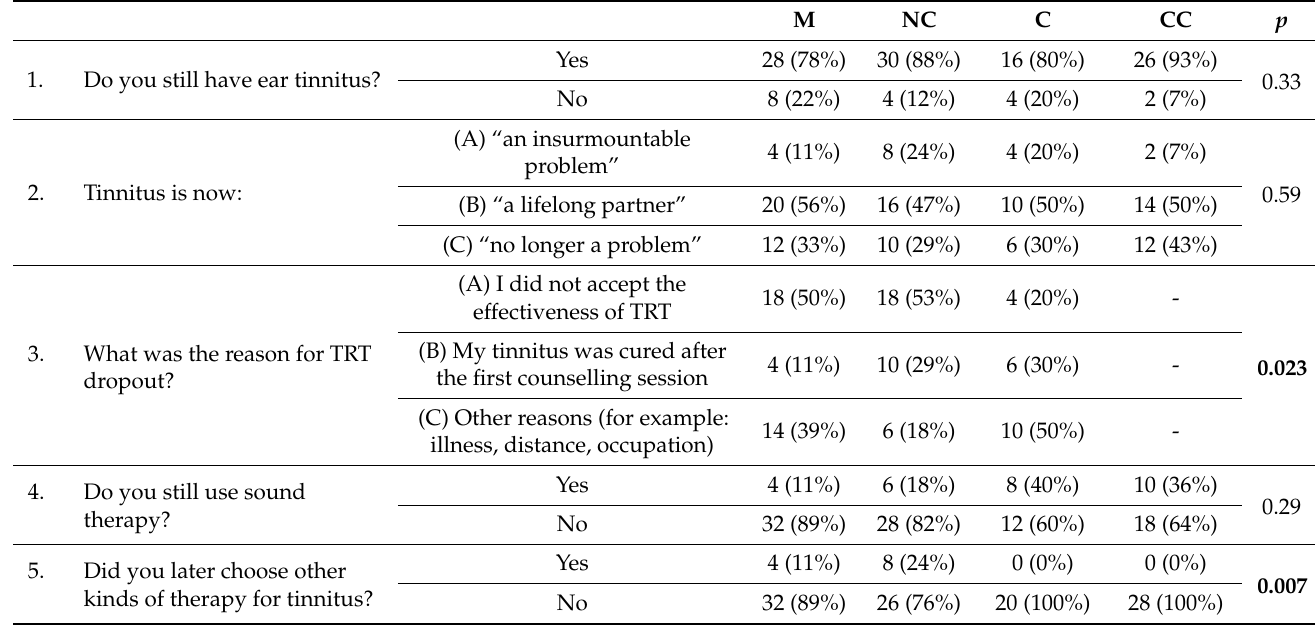
Table 1. Telephone survey questionnaire and distribution of answers with associated statistical analysis (Pearson’s Chi- squared